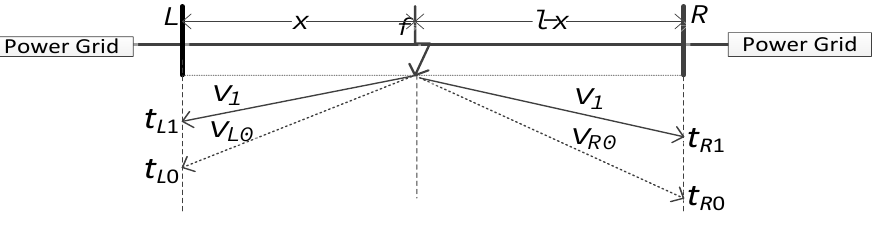
Figure 7. A time-space diagram for a line monitored at two line terminals.